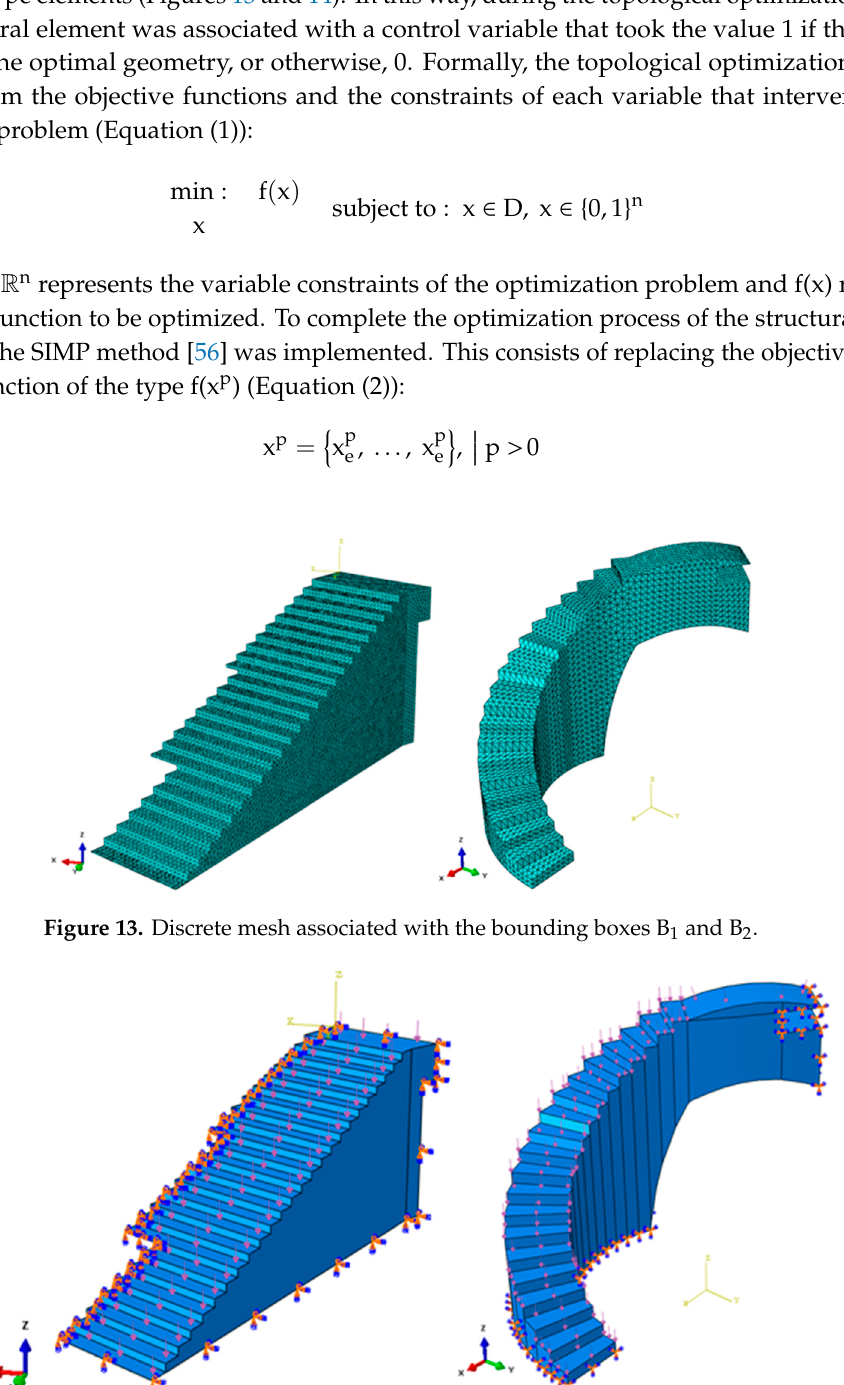
Figure 15. Evolution of the geometry of the bounding box B 1 throughout the topological optimization process.